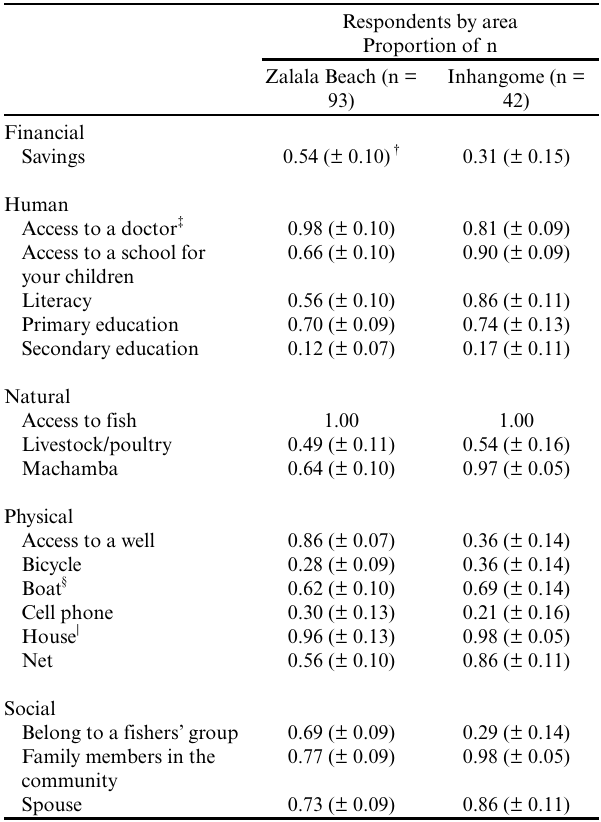
Table 1 . Summary of assets across the two study communities. Values indicate the proportion of total respondents in each community who positively identified ownership of or access to each asset in household surveys.